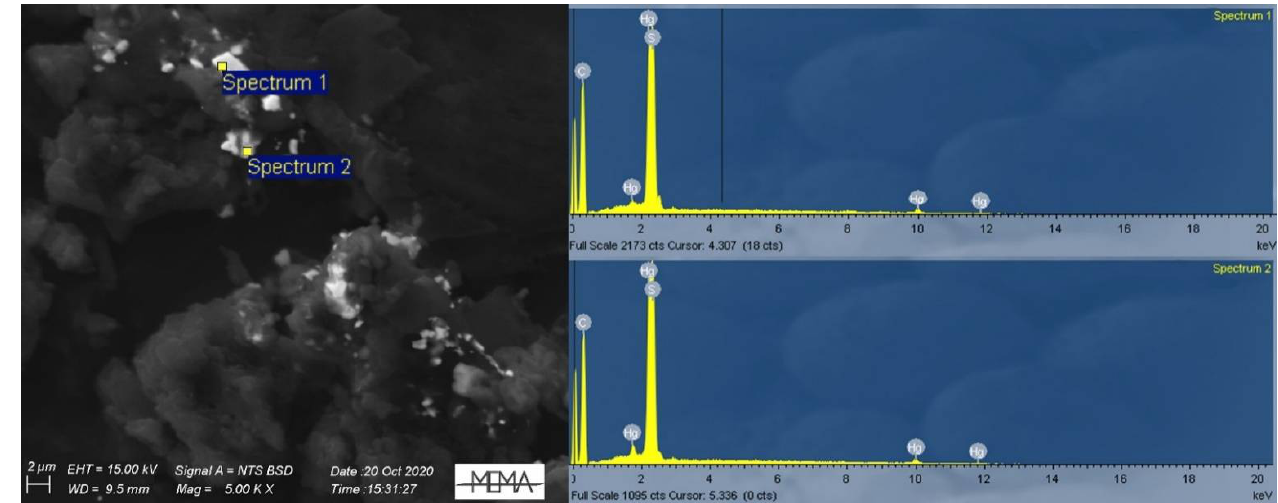
Figure 4. Mix SE and BSE image of the Hg-S compounds found in the 2020 W-AD, and the associated spectra of EDS analysis displaying Hg and S.